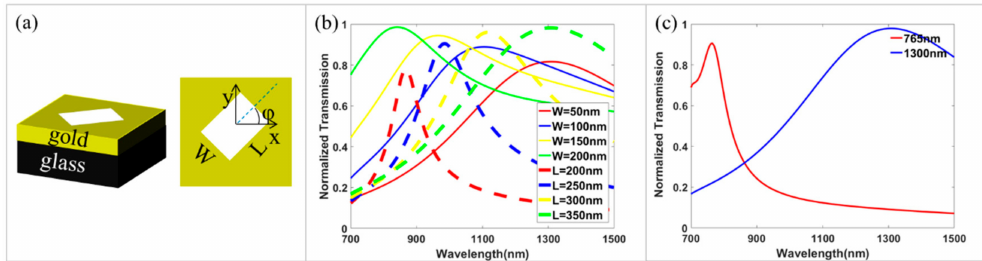
Figure 1. ( a ) 3D view and top view of basic unit cells. ( b ) Transmission of the rectangle gap nanoantennas (RGN) (with di ff erent L and W) as a function of the wavelength. ( c ) The normalized transmission of two RGNs under normal left circularly polarized (LCP) incidence light with the wavelength from 700 nm to 1500 nm.